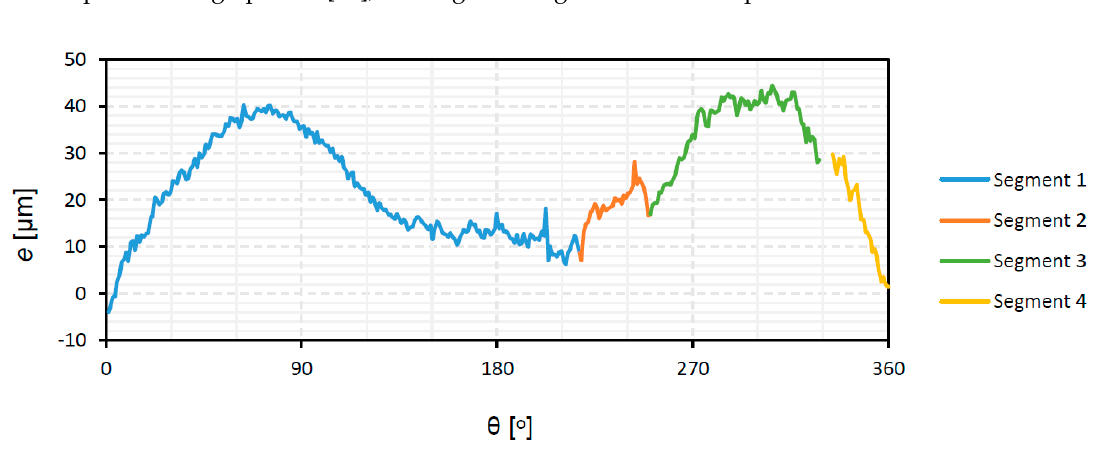
Figure 16. Shape error of the WEDM cam.